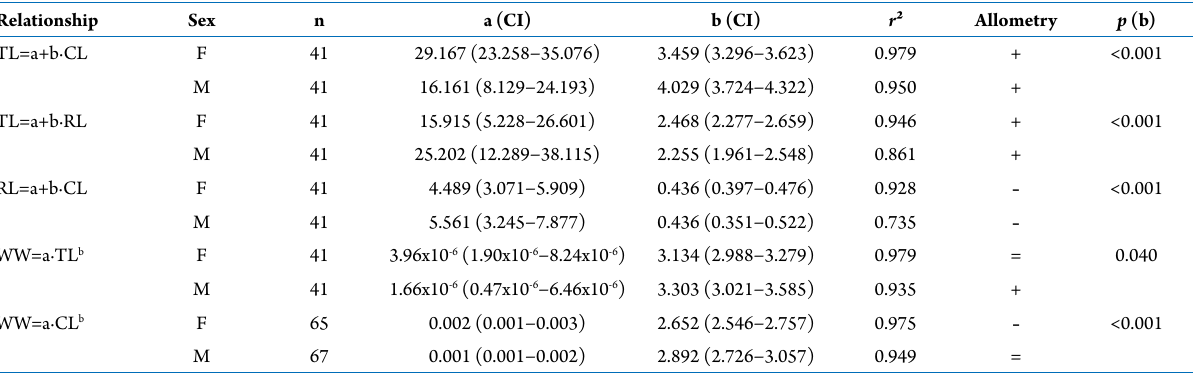
Table 2. Intercept (a) and slope (b) for length-length and weight-length relationships for females (F), and males (M) of Farfantepenaeus brasiliensis (Latreille, 1817) caught on the coast of Sergipe, northeastern Brazil. TL = total length, CL = carapace length, RL = rostrum length, WW = wet weight, n = sample size, CI = confidence interval, r² = coefficient of determination, p (b) = values of p for the analysis of covariance used to compare values of b from relationships estimated for females and